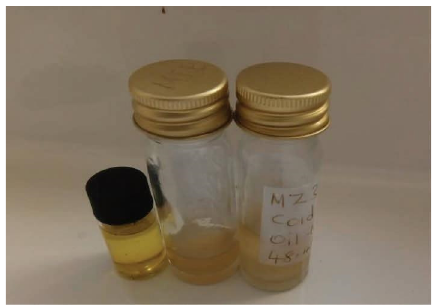
Figure 4: Sclerocarya birrea seed oil in glass